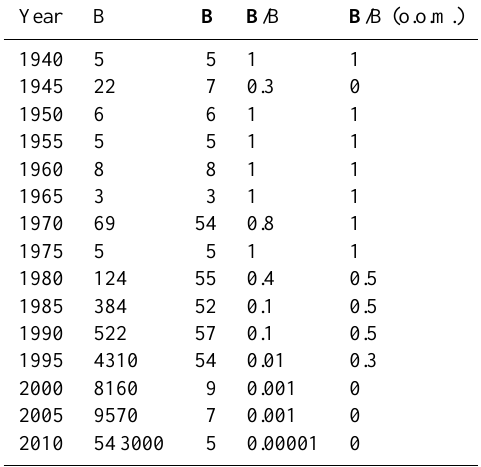
Table 1. Google Scholar analysis of the occurrence of the following terms in the ecological literature: B – biodiversity; B – biodiversity, abundance, numerosity, richness, evenness, and profiles. The abbre- viation o.o.m indicates order of